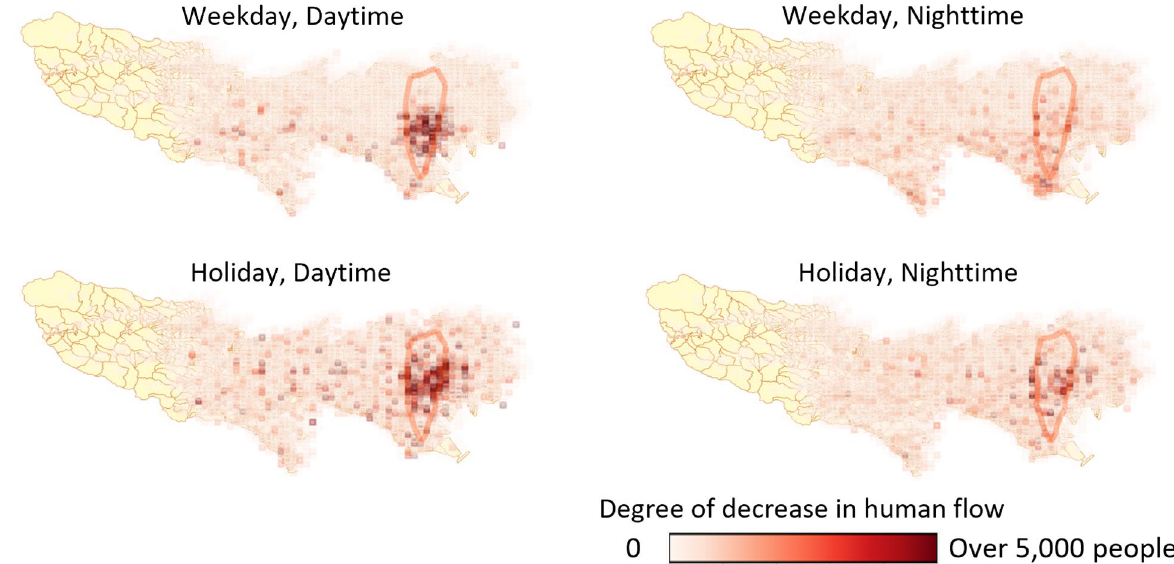
Figure 4. Comparison of Tokyo’s human flow in the first wave and a year before, with a heat map showing the degree of decline that occurred after SARS-CoV2. The circles in the map indicate the Yamanote Line (Tokyo’s loop train line), i.e., the downtown area.